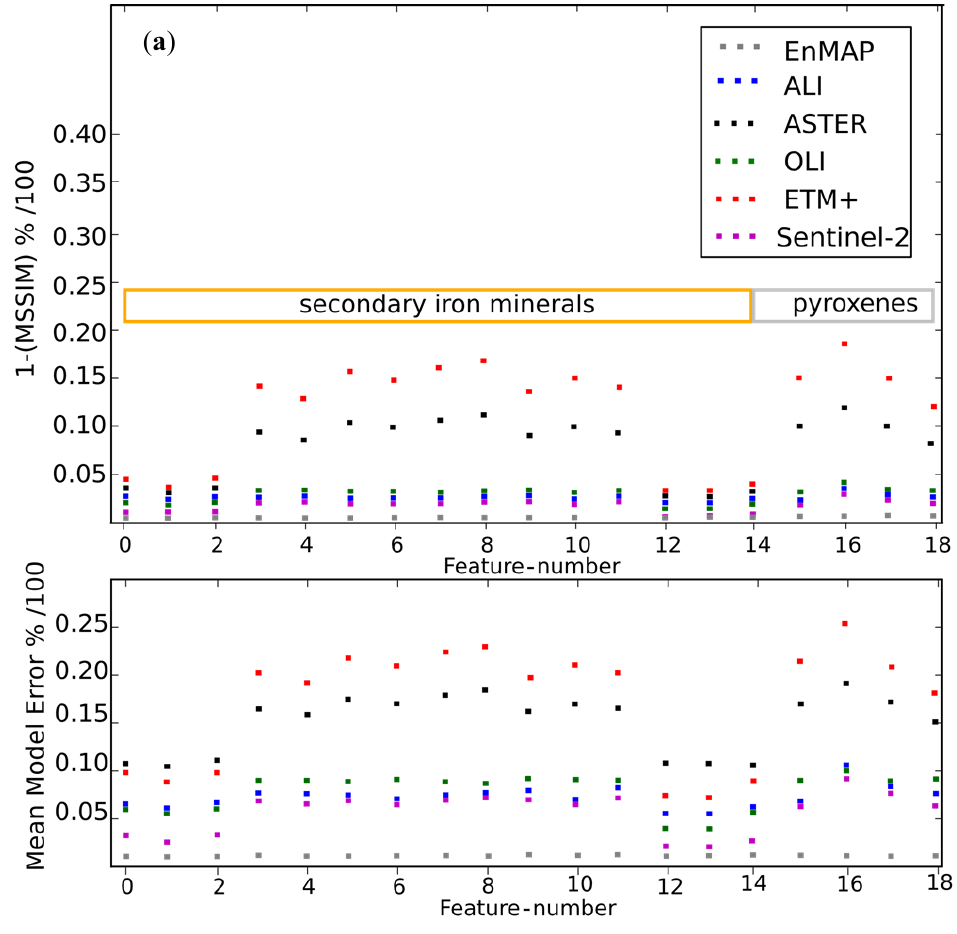
Figure 5. Band comparison of multispectral and hyperspectral sensors for sample spectra from the Merensky Reef mine waste site ( a ), shown directly below, and from spectra from the Chem Wes footprint mine waste site ( b ), shown below (a). Errors displayed were computed between the HySpex reference and the resampled multispectral sensors for the iron absorption features listed in Table S1. EnMAP with an offset of 0.01 is shown for reference purposes only. Note the large deviation of ETM+ (above 15%) and ASTER in the pyroxene region from mineral feature-number 14 (see Table S1) onwards as pyroxenes are a major component of the platinum group element (PGE)-bearing rocks (a). Large deviations are also found in ETM + and ASTER in the region of secondary iron minerals up until 14 at the Chem Wes Site (b), as these minerals are indicative of acid rock drainage generation on tailings dam